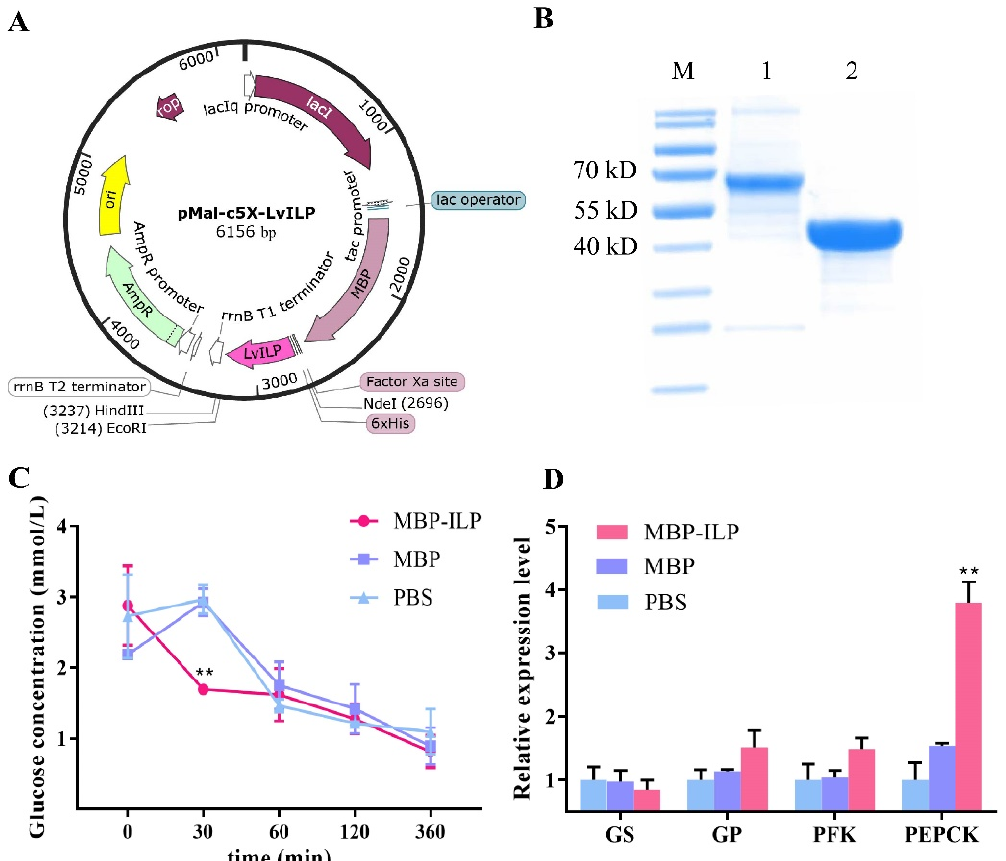
Figure 4. Effects of the recombinant maltose-binding protein (MBP)–LvILP protein injection on hemolymph glucose and the expressions of glucose metabolism-related genes. ( A ) The recombinant plasmid map of pMal-c5X-LvILP. ( B ) Sodium dodecyl sulfate-polyacrylamide gel electrophoresis (SDS-PAGE) electrophoresis of the recombinant MBP–ILP protein and the MBP protein. ‘M’ indicates a PageRuler TM prestained protein ladder (Thermo Fisher Scientific, 26619); ‘1’ indicates purified MBP-ILP protein (63 kD); and ‘2’ indicates purified MBP protein (45 kD). ( C ) The variation curve of hemolymph glucose concentration within 6 h after recombinant LvILP protein injection. ( D ) The relative expression levels of GS , GP , PFK , and PEPCK at 12 h after injection of recombinant ILP protein. The gene expression levels were detected by RT-qPCR, and 18 S rRNA was used as an internal reference. Error bars indicate the mean ± SD of three replicate samples. Statistical significances are shown as ** p <